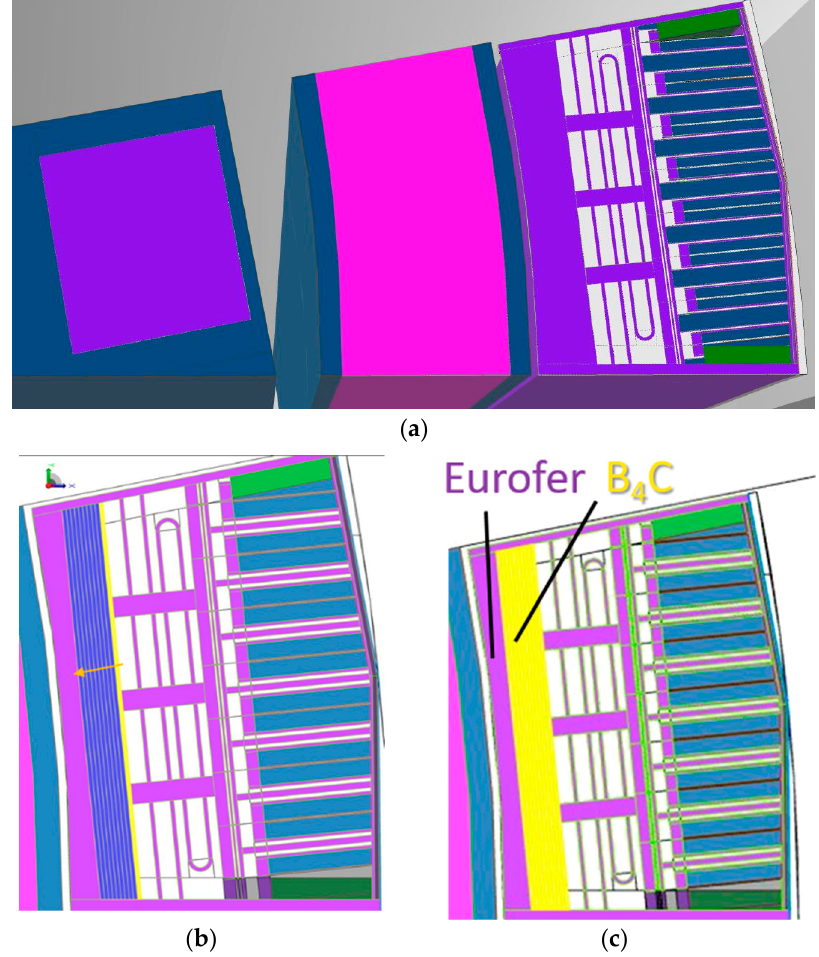
Figure 4. ( a ) HCPB baseline configuration with 15 cm Eurofer BSS (violet); ( b ) configuration v1 with 1 cm of B 4 C (yellow) and 14 cm of Eurofer, with the arrow showing the direction of increasing B 4 C shielding thickness from 1 cm (v1) to 10 cm of B 4 C (v10); ( c ) configuration v10 with 10 cm B 4 C (yellow) and approximately 5 cm of Eurofer (violet).